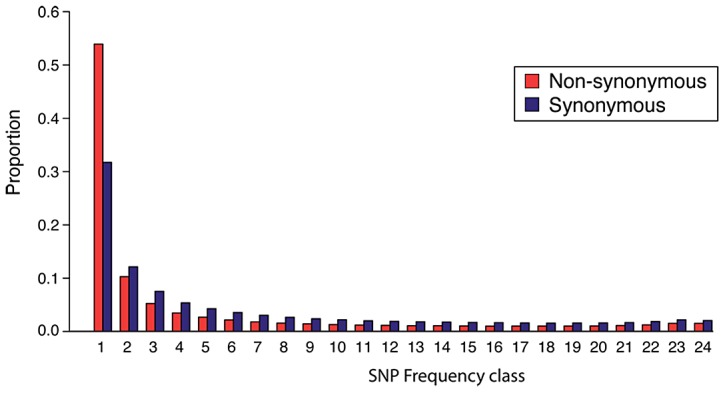
The site frequency spectrum of A. arenosa.Folded site frequency spectrum (SFS) of single nucleotide polymorphisms (SNPs) in A. arenosa protein-coding sequences. Each column indicates the abundance of SNPs that fall into a particular frequency class and columns are color-coded to indicate non-synonymous sites (red) and synonymous sites (blue). There is a significant skew toward low-frequency mutations at non-synonymous sites (red) compared to synonymous sites (dark blue) (Mann-Whitney U Test p<7×10−8).